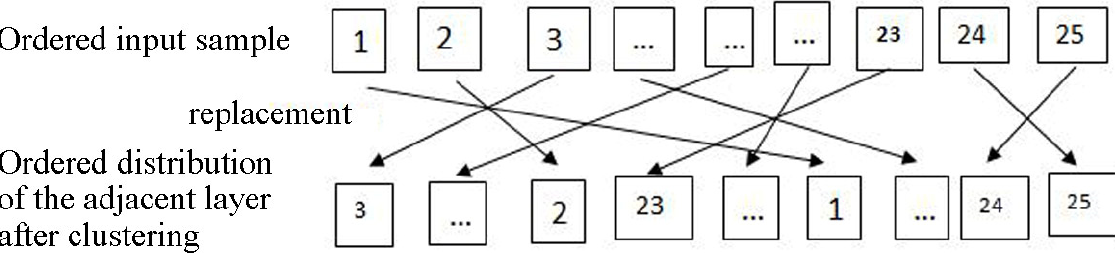
Figure 6. Ordering of the increment and ranked adjacent layer of the neural network.